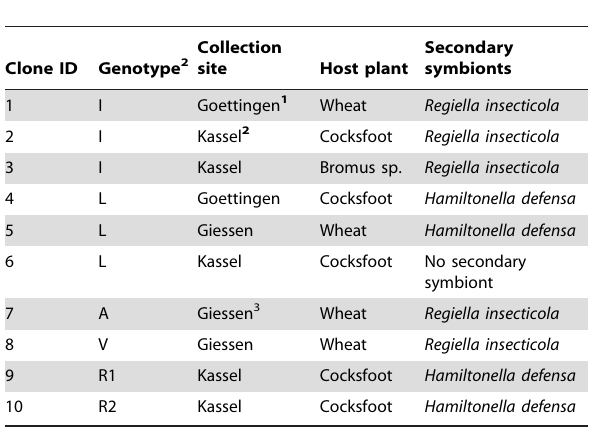
Table 1. Collection sites, genotype and secondary symbionts of Sitobion avenae clones tested on 10 cocksfoot